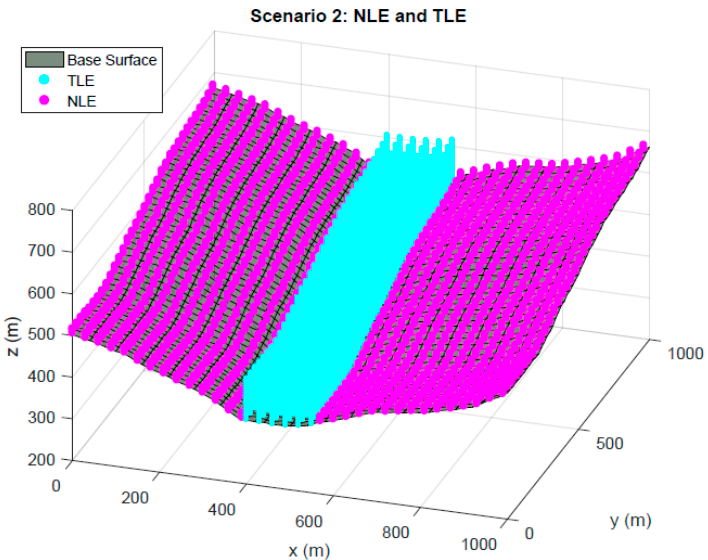
Figure 3. Scenario 2. Second environment representation for optimization with Genetic Algorithms – (GA). TLE region is limited to the center of the domain. NLE space extends all over the base surface, except for TLE region.